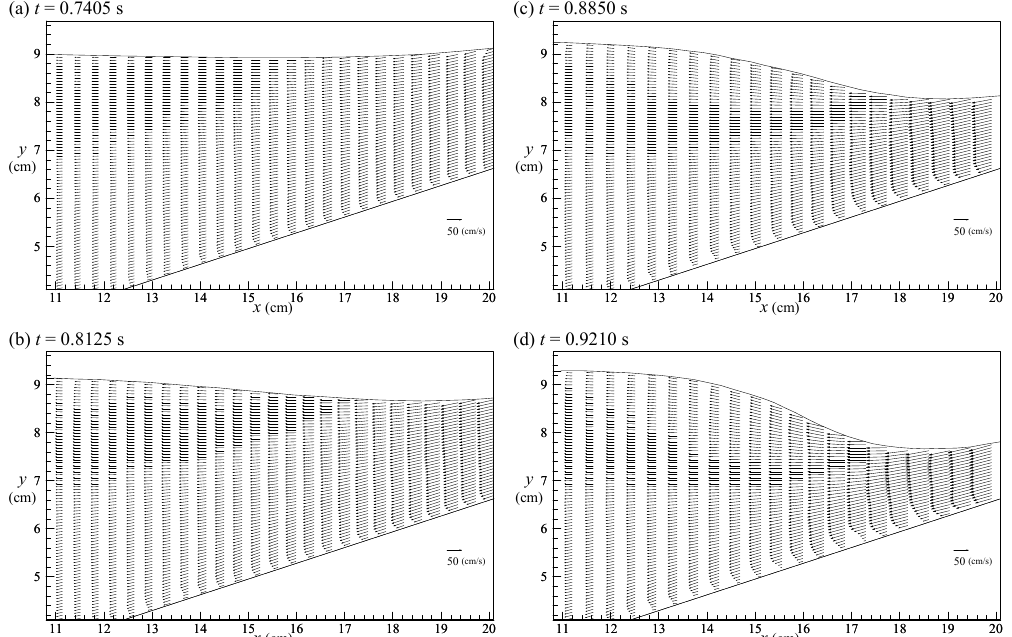
Figure 9. The spatio-temporal variation of the free surface profiles and the velocity fields at t = ( a ) 0.7405 s; ( b ) 0.8125 s; ( c ) 0.8850 s; and ( d ) 0.9210 s.